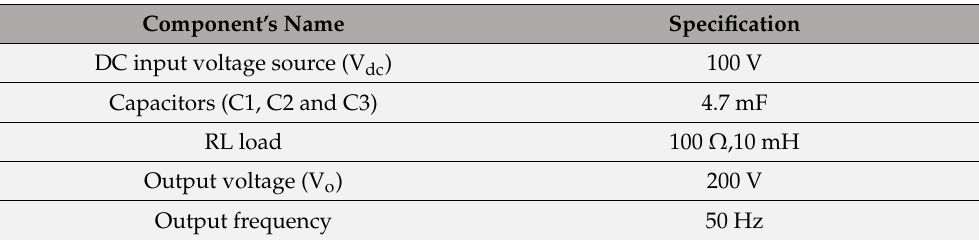
Table 2. Components and parameters of nine-level